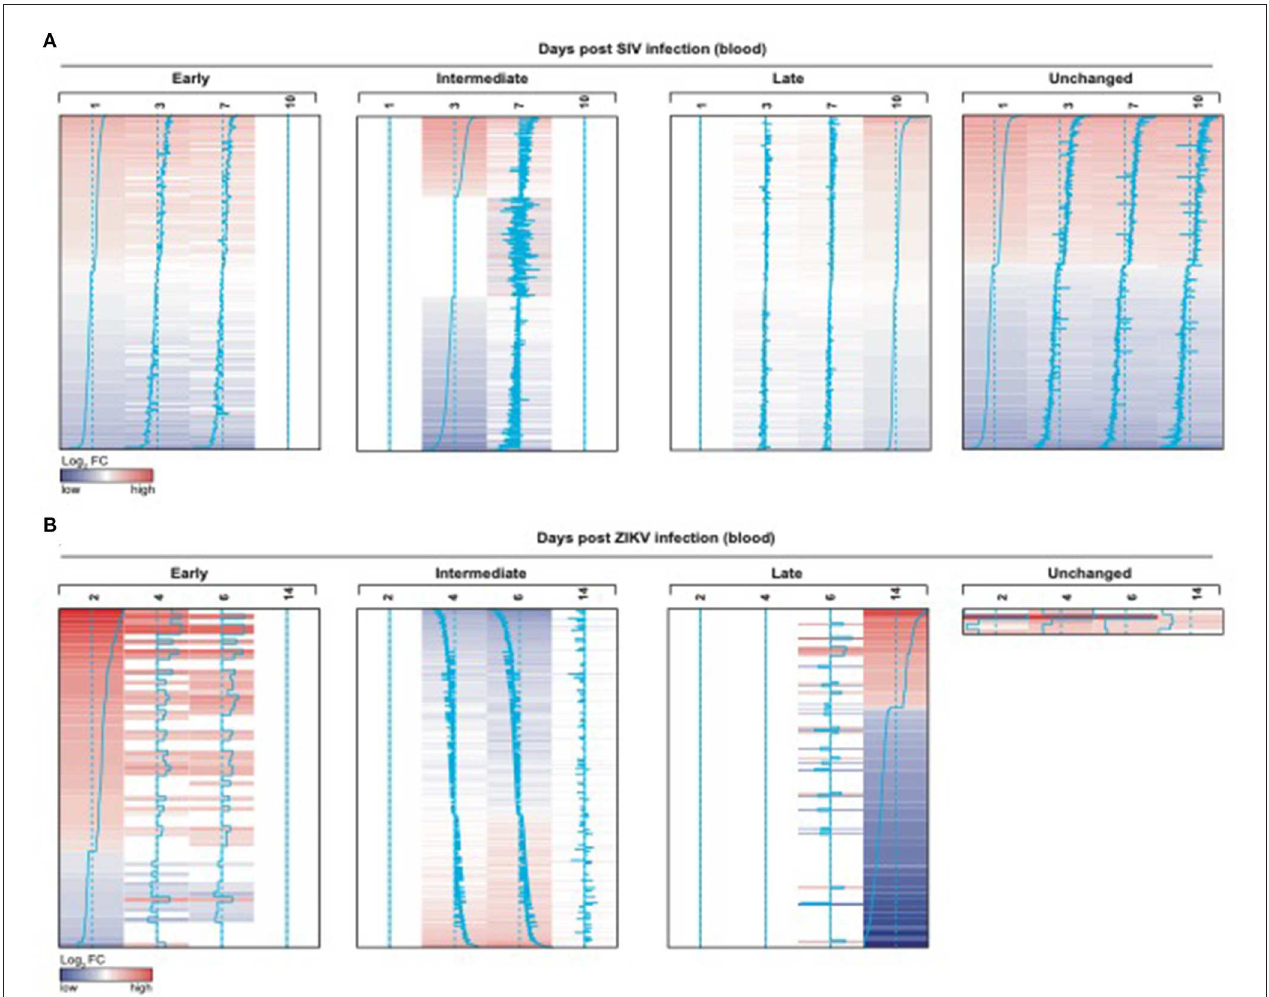
FIGURE 8 | NK RMtsig is modulated following SIV and ZIKV infections in blood from two independent NHP cohorts. (A,B) NK RMtsig upregulated (red) or down regulated (blue) genes following SIV infection (A) on days 1, 3, 7 and 10 (post-infection) compared to day 0 (before infection) and following ZIKV infection (B) on days 2, 4, 6 and 14 (post-infection) compared to day 0 (before infection). Heatmaps represent the log 2 fold change expression of all significant NK RMtsig genes (Adjusted p < 0.05) compared to day 0. Genes were grouped using their expression profiles into 4 clusters: early (day 1 or 2), intermediate (days 3, 4, 6, or 7), late (day 10 or 14) or